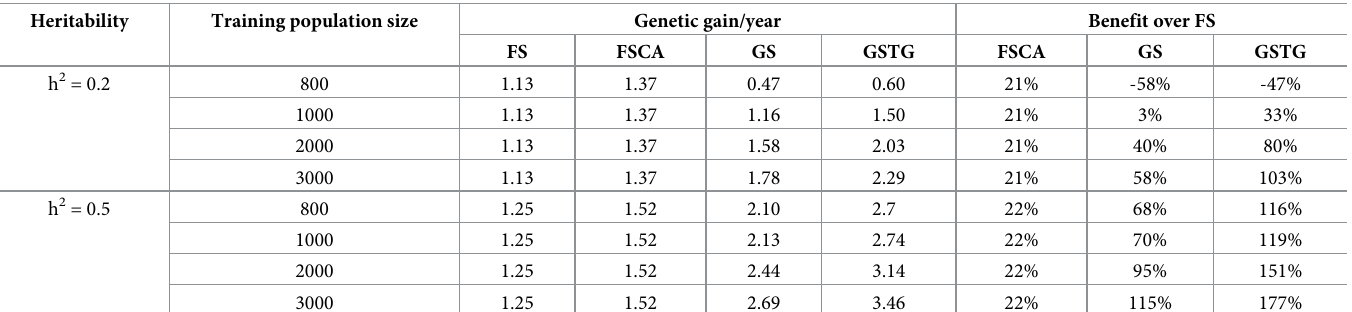
Table 6. Genetic gain per year obtained in the breeding population from genomic selection with (GSTG) or without (GS) top grafting and from forward selection with (FSCA) and without (FS) clonal archive for traits with low (h 2 = 0.2) or high (h 2 = 0.5) heritabilities for various training population sizes of 800, 1,000, 2,000 and 3,000. GEBVs were estimated using a 60K SNP